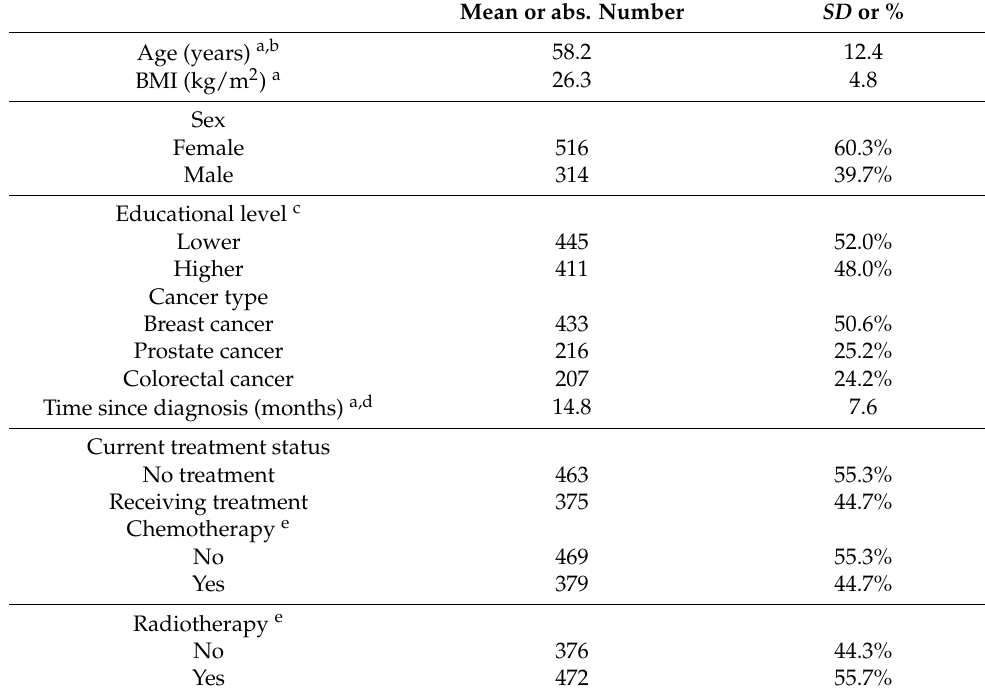
Figure 2. Recruitment flow. Adapted from ‘Change patterns and determinants of physical activity differ between breast, prostate and colorectal cancer patients,’ by K. Steindorf, 2020, Support Care Cancer [9] . Copyright 2019 by Springer-Verlag GmbH Germany, part of Springer Nature. Table 1. Descriptive statistics of sample characteristics ( n = 856). Mean or abs.